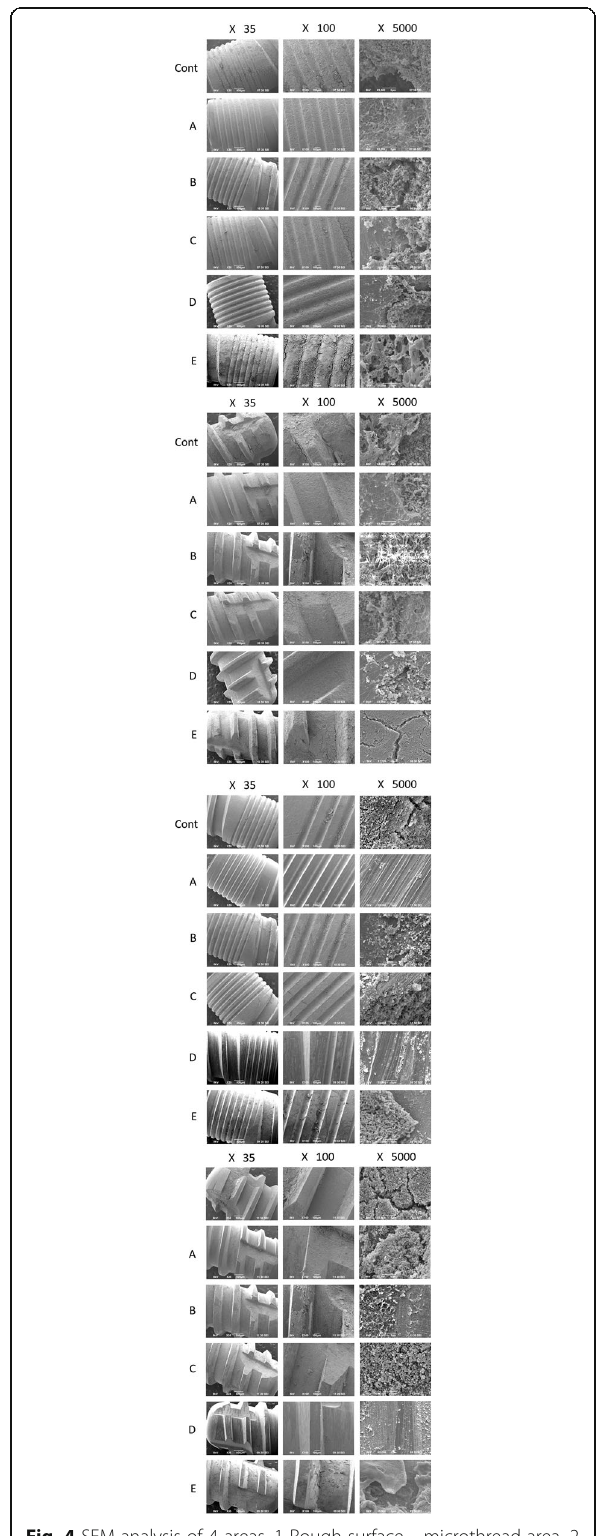
Fig. 4 SEM analysis of 4 areas. 1 Rough surface — microthread area. 2 Rough surface — macrothread area. 3 Machined surface — microthread area. 4 Machined surface — macrothread